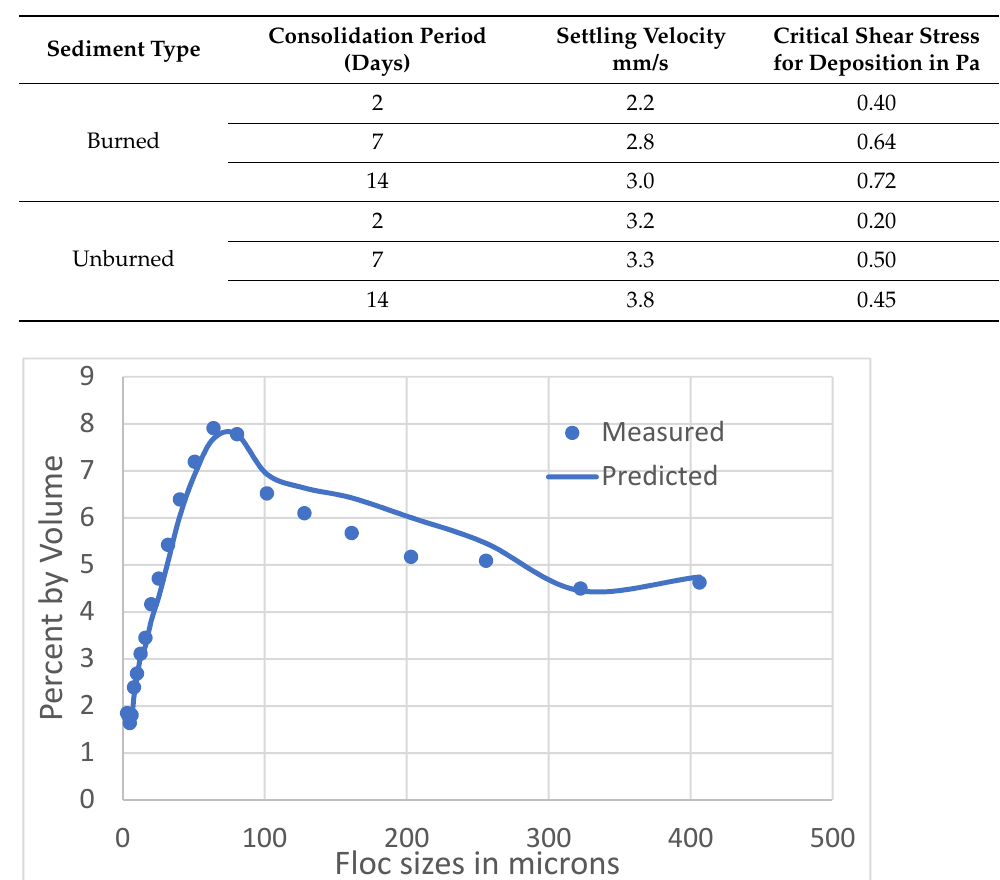
Table 5. Critical shear stresses for deposition of sediment (Krone’s definition).